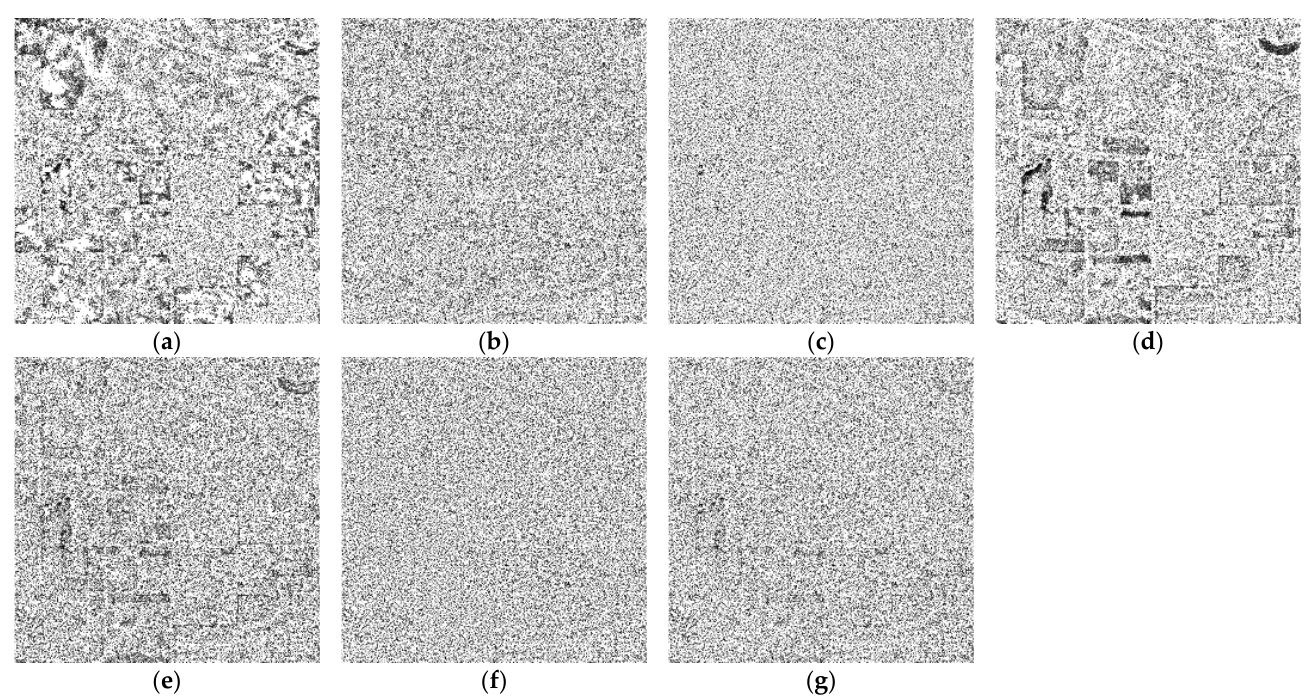
Figure 10. The corresponding ratio images for S1. ( a ) W-C; ( b ) PPB; ( c ) SAR-BM3D; ( d ) H-WNNM; ( e ) GNLM; ( f ) FANS; ( g ) Proposed method.